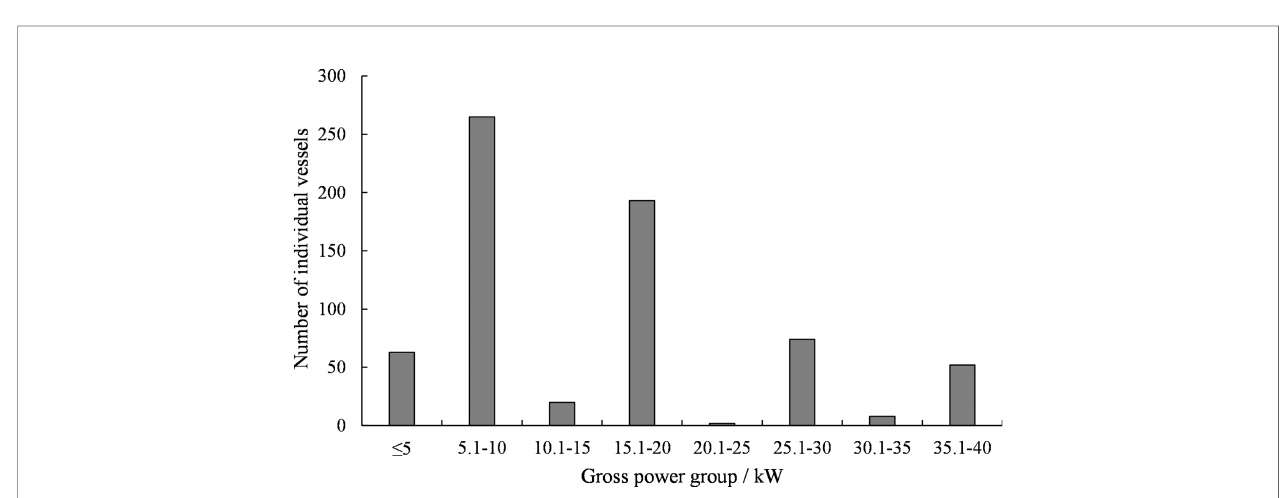
FIGURE 5 | Number of vessels per gross power category(in kW) for small-scale fi sheries in Shengsi